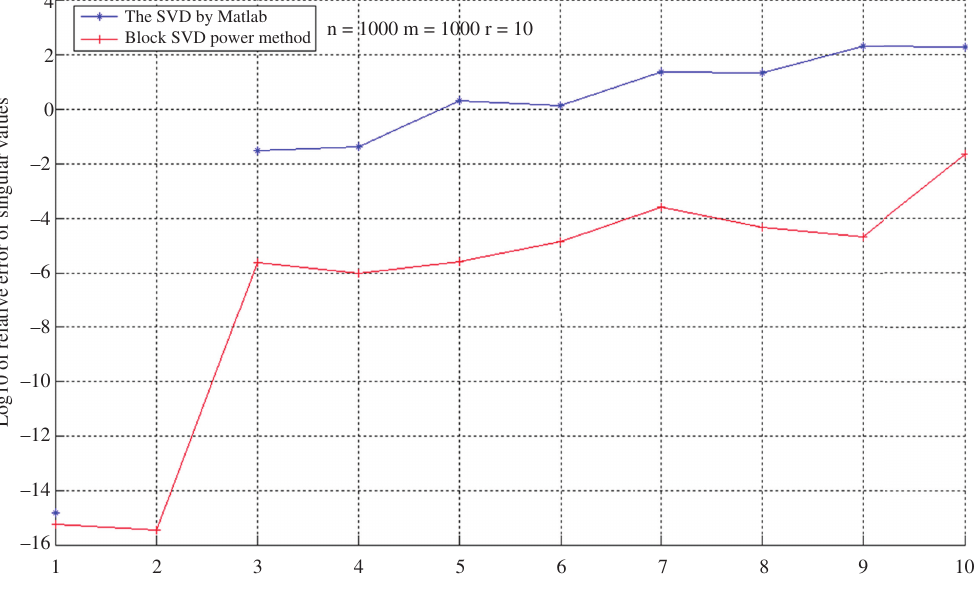
Figure 3: Relative Errors Occurring When Computing the Singular Values.